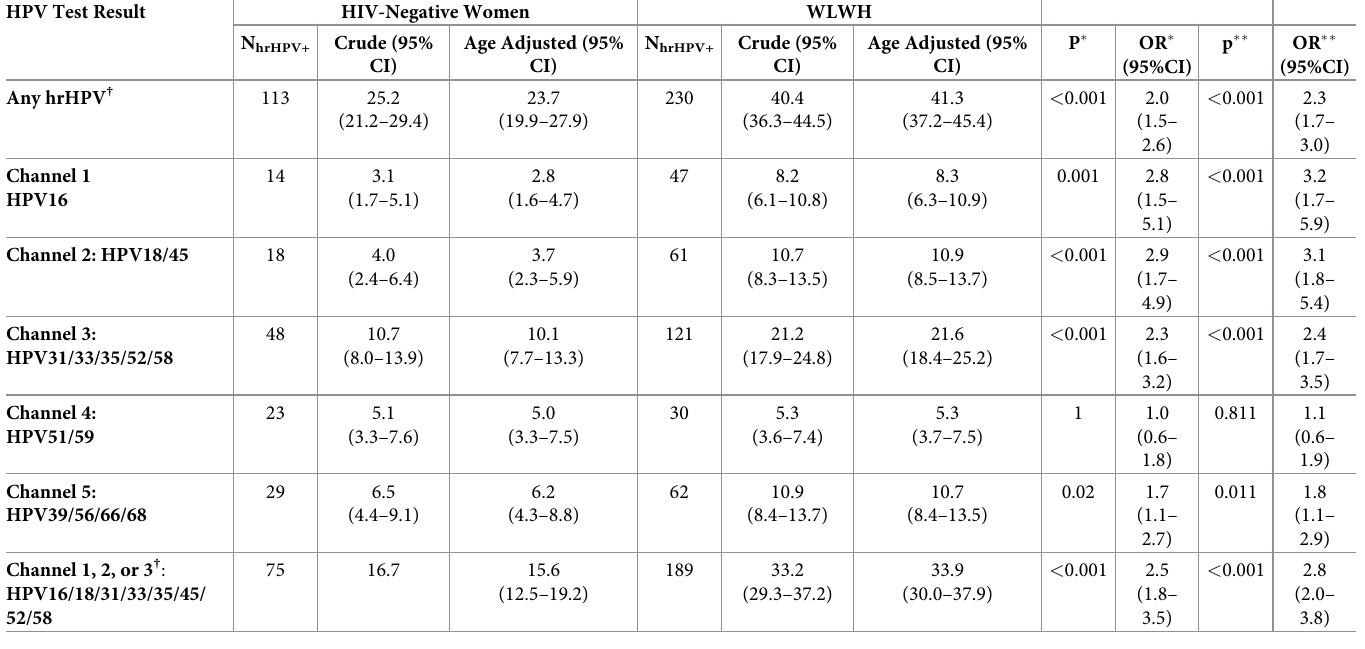
Table 1. Prevalence of high-risk human papillomavirus (hrHPV) overall and individual hrHPV groups, as detected by the Xpert HPV Test, for human immunodefi- ciency virus (HIV)-negative women (n = 449) and women living with HIV (WLWH) (n = 570).